Question: What kind of plot is shown here?
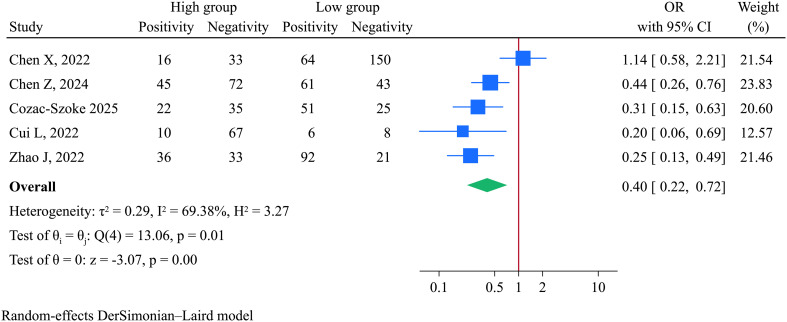
Answer: forest